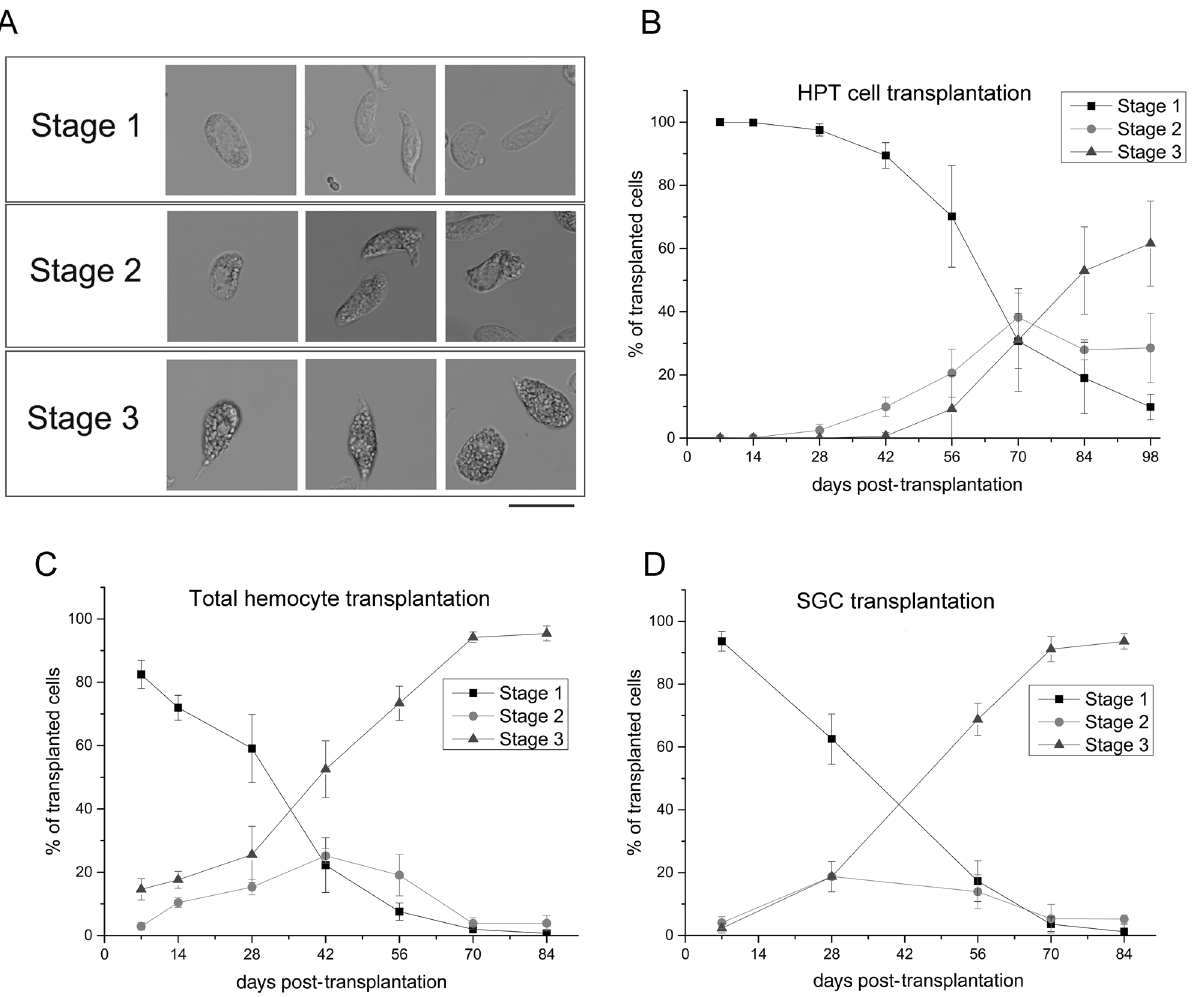
Figure 6. The development of transplanted cells can be divided into three stages. In the transplantation experiments, the differentiation and maturation of hemocytes could be roughly separated into three morphological stages (Stage-1, -2, -3) based on light microscopy observations ( A ). Stage-1, early hemocytes with no/some small granules; Stage-2, cells with some medium size granules; Stage-3, mature cells filled with many large granules. The changes in the proportions of cells in these three stages during the developmental process are shown: ( B ) HPT cell transplantation; ( C ) total hemocyte transplantation; ( D ) SGC transplantation. Bar, 25 marker) 46 . Purified SGCs and GCs were used as the controls. As shown in Fig. 7A, most cells developed into GCs (with numerous cytoplasmic granules) within 21 days of induction. The expression of PCNA was relatively high in uninduced HPT cells and early-differentiated (3–7 days post-induction) cells and gradually reduced with the progression of differentiation. The expression of the GC markers MBP and peroxinectin was not detectable until 14 days post-induction. The SGC markers were not very specific. They were highly expressed in SGCs but also expressed in GC (KPI, peptidase) or HPT cells (KPI, hemolectin, and CHF) at different levels. The expression of hemolectin, CHF, and peptidase was detected in undifferentiated cells and cells induced for 3–14 days with a gradual reduction, but not in late-differentiated cells (21 days post-induction). KPI was detected in all the cells we analyzed. Despite the nonspecificity of some marker genes, the change in the gene expression pattern from undifferentiated HPT cells to SGCs and finally to GCs was clearly observed in the process of GC differentiation (Figs. 7B and S4). Hemocytes of different developmental stages are capable of phagocytosis. To determine whether hemocytes of different developmental stages are functional immune cells, we performed an in vivo phagocytosis assay. Animals were injected with fluorescence microspheres, and hemolymph samples were ana- lyzed at 4 hpi. We found that cells belonging to all three stages were capable of phagocytosis (Fig. S5). In our experiment, the overall phagocytic rate of circulating hemocytes was normally < 7%. Stage-1, -2, and -3 cells accounted for approximately 65%, 15%, and 20% of the phagocytic population, respectively. Notably, for each stage, only a small portion of cells were phagocytic cells, even though an excessive number of microspheres were